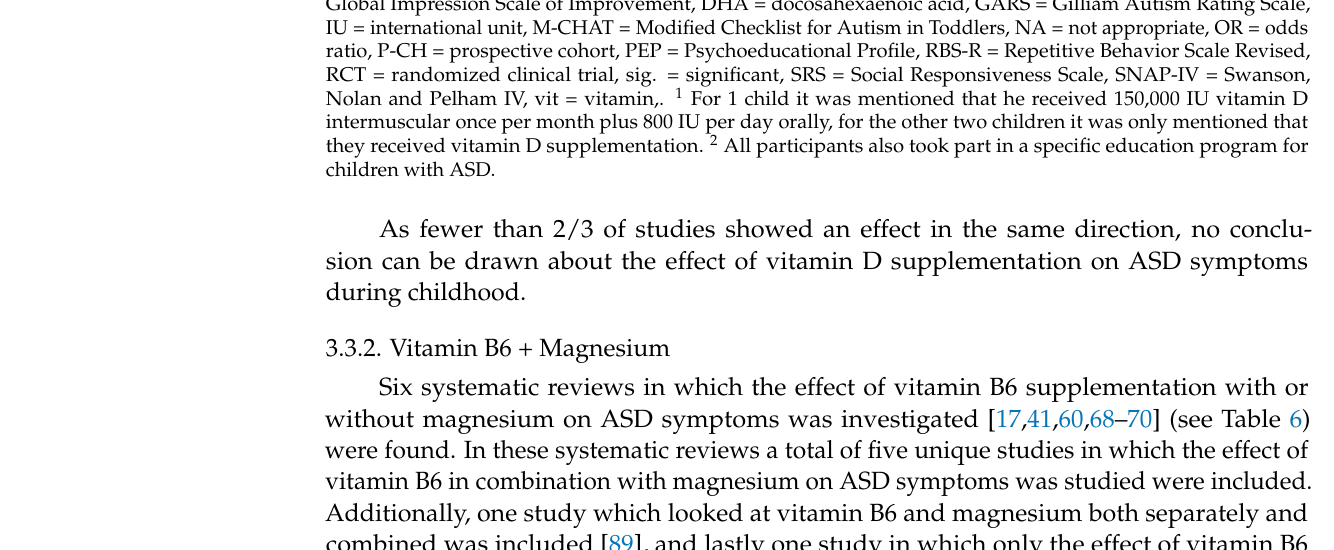
Nosig. changeinautismseverityfrom baseline. Nosig. differenceinautism GARS severitybetweenactiveand